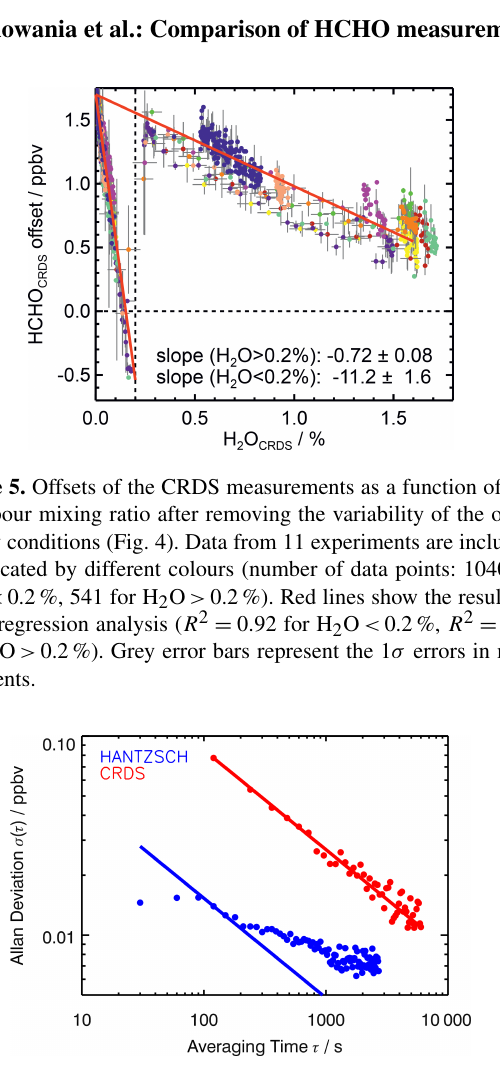
Figure 6. Allan deviations (1 σ precision) calculated from zero mea- surements in the clean, dark chamber. Straight lines represent the white noise ( σ(τ) 2 ∝ τ − 1 ).